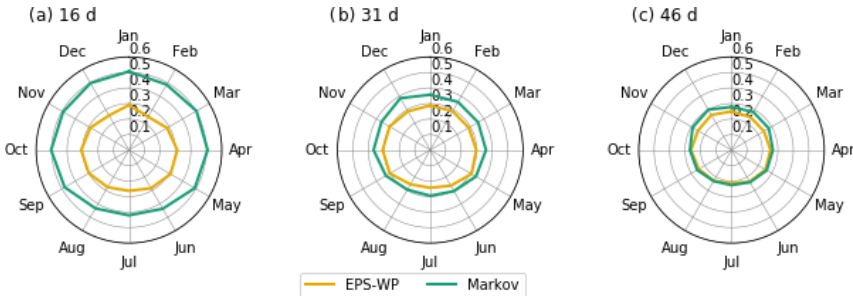
Figure 3. Jensen–Shannon divergence scores for EPS-WP and Markov models for three lead